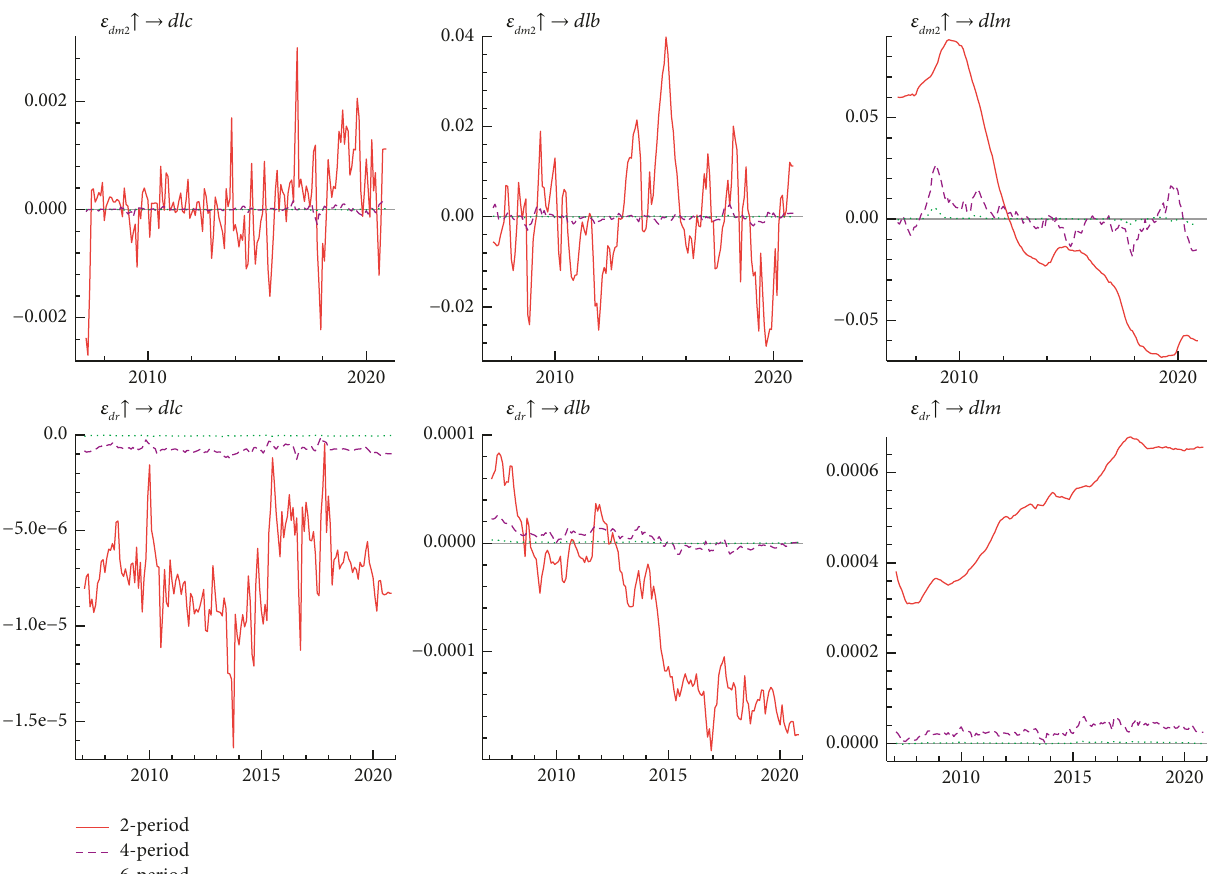
Figure 7: The impulse responses of monetary policy to liquidity with an equal